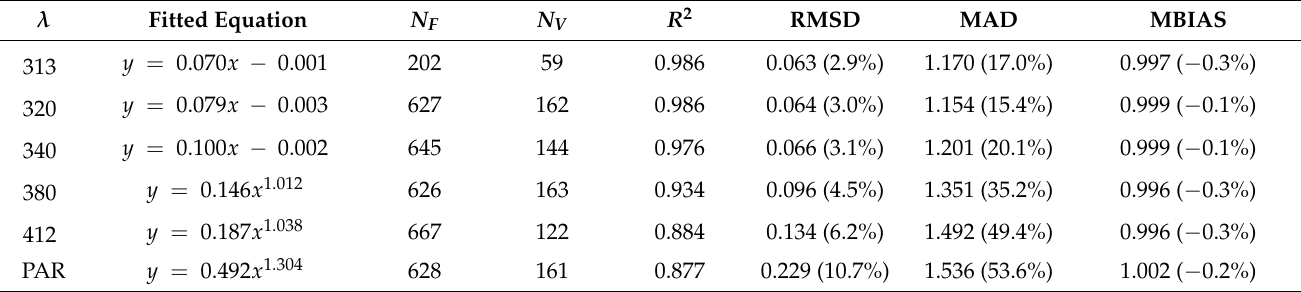
Table 1. The one-band K d ( λ ) algorithms, organized spectrally with individual λ values in units of nanometers, and based on linear and power functions as appropriate, i.e., y = mx + b and y = ax k , respectively. The N F and N V variables usually differ from wavelength to wavelength, because of the random selection process used with the cross-validation technique (Section 2.4). The equivalents for the RMSD, MAD, and MBIAS terms expressed in percent are indicated in parentheses for all three